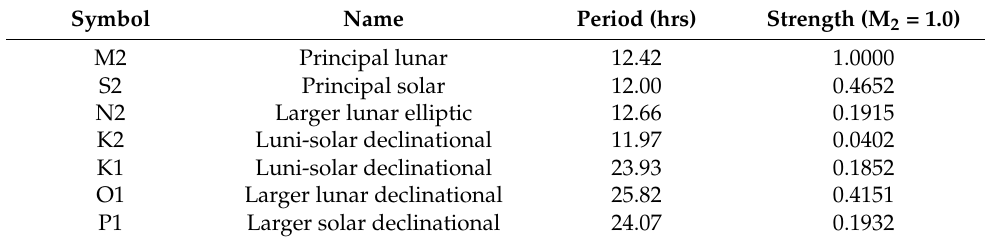
Table 1. Main tidal constituents with relative